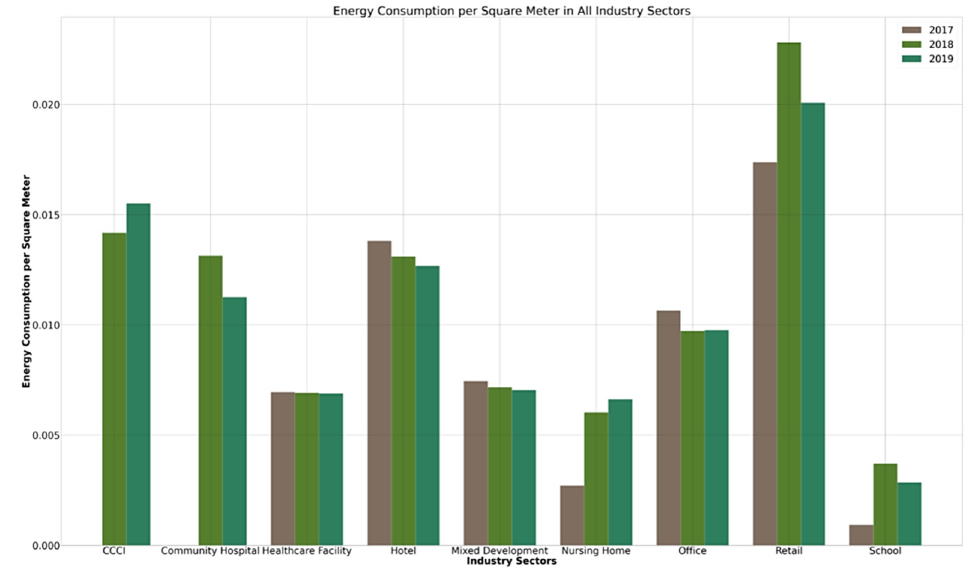
Figure 13. Energy consumption of commercial industry sectors per square meter. Table 5. Comparison of Platinum and GoldPlus awards in hotel, retail, and office sectors. Green Mark Award